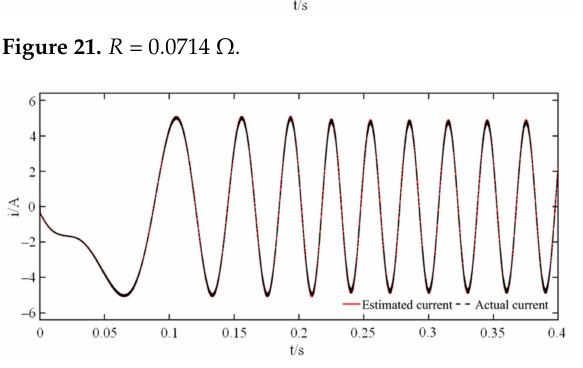
Figure 22. R = 0.1326 Ω .